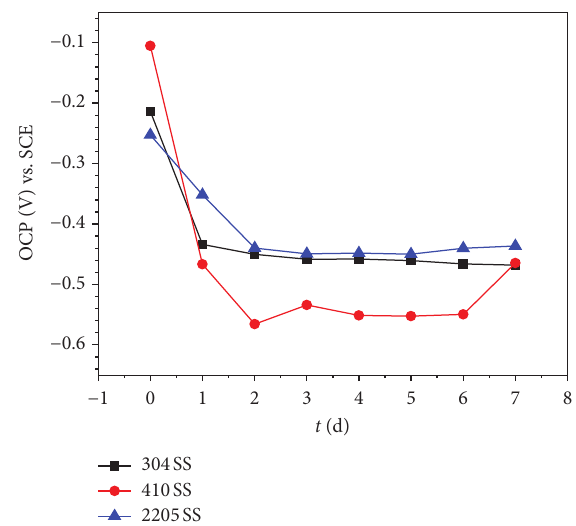
Figure 6: OCP versus time during 7-day